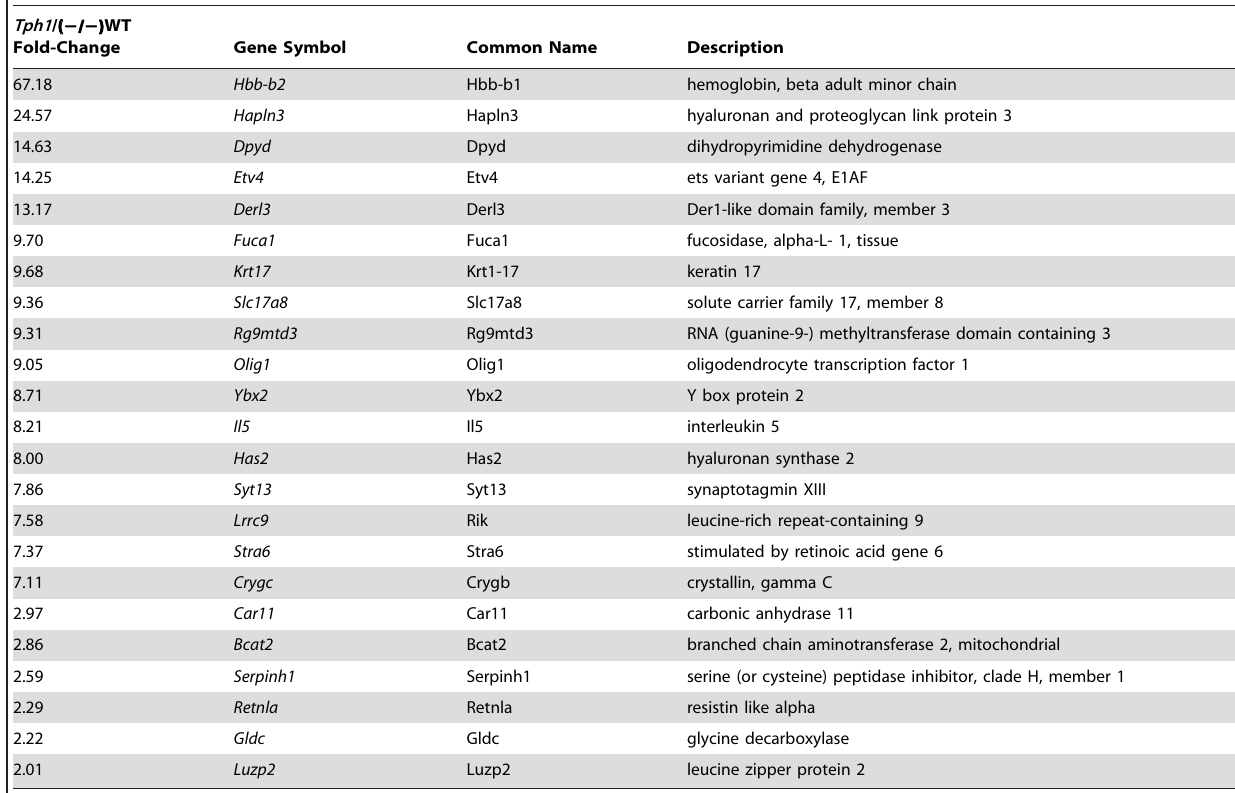
These data were generated from lung tissue harvested from WT and Tph1 ( 2 / 2 ) female mice (n=6 per group). The above changes were statistically significant (p , 0.025).